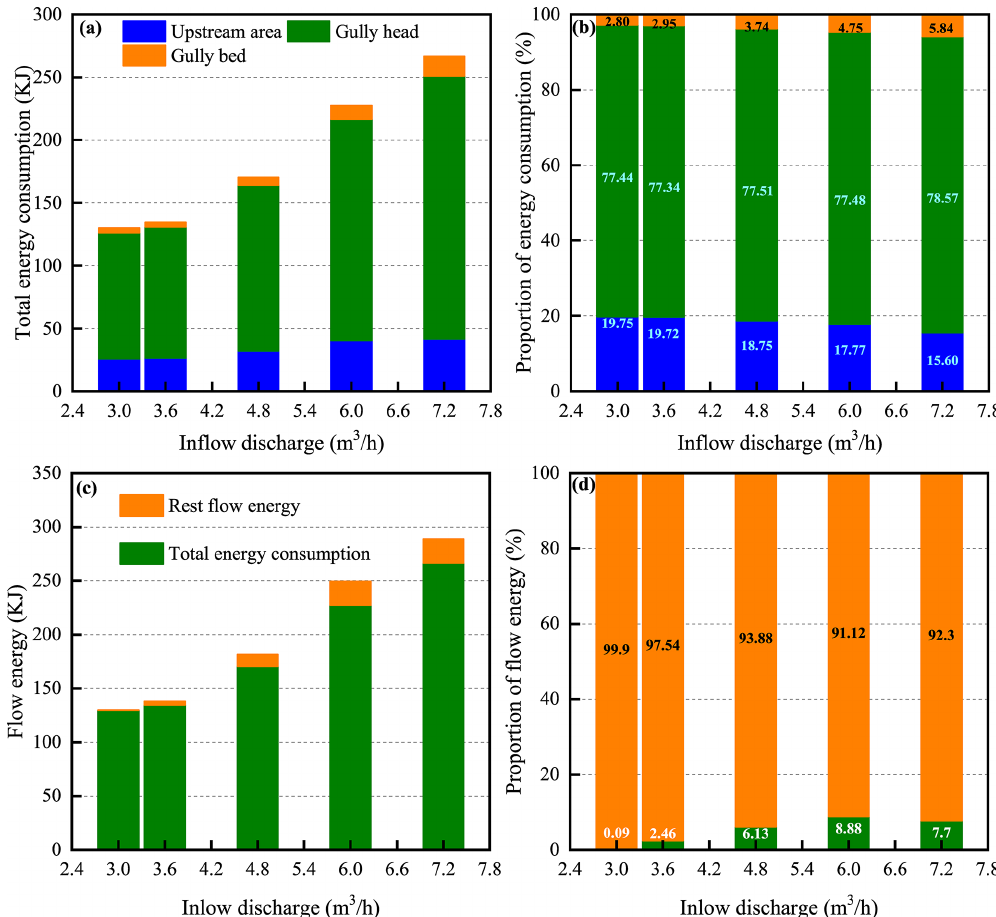
Figure 9. Total energy consumption (a) and their proportions (b) of upstream area, gully head, and gully bed, and the total energy consump- tion and rest flow energy (c) and their proportions (d) under different inflow discharge